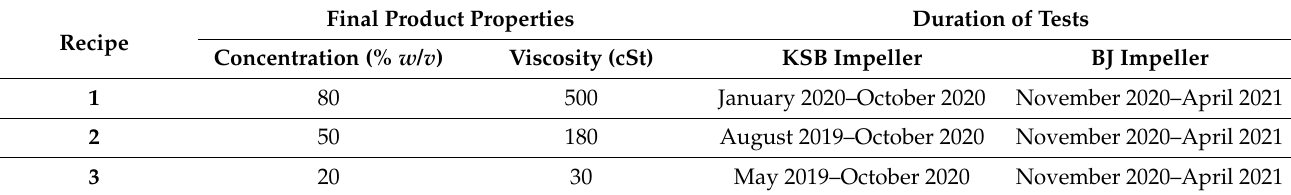
Table 2. Product recipe compositions and test